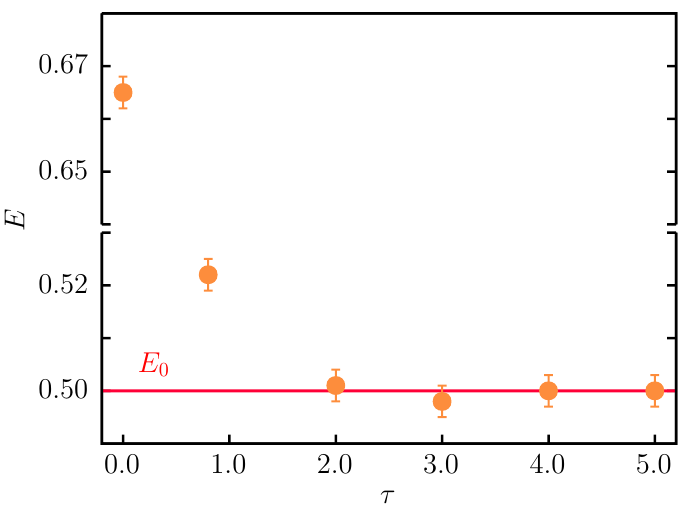
Figure 5: Evolution to the ground state energy of the harmonic oscillator obtained using the mixed estimator. Dots represent the average energy as a function of the imaginary time τ = 2 M δτ . The solid line represents the analytical value of the = 1 / 2. E ( τ = 0 ) is the variational ground state energy E 0